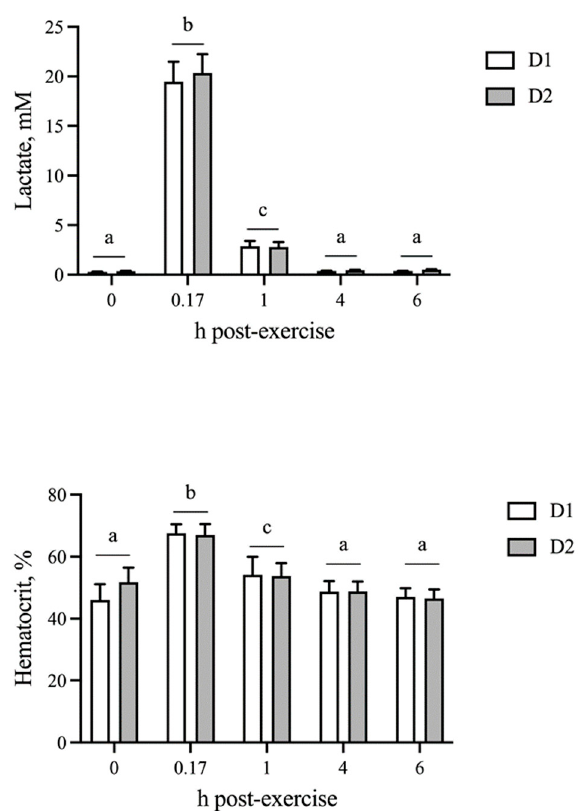
Figure 1. Blood lactate and hematocrit responses following sequential bouts of exercise. Blood lactate and hematocrit increase at 10 min post-exercise, followed by a decline to baseline by 4 h on both days of exercise. Means and SEMs are shown. Different letters indicate significance at p < 0.05.